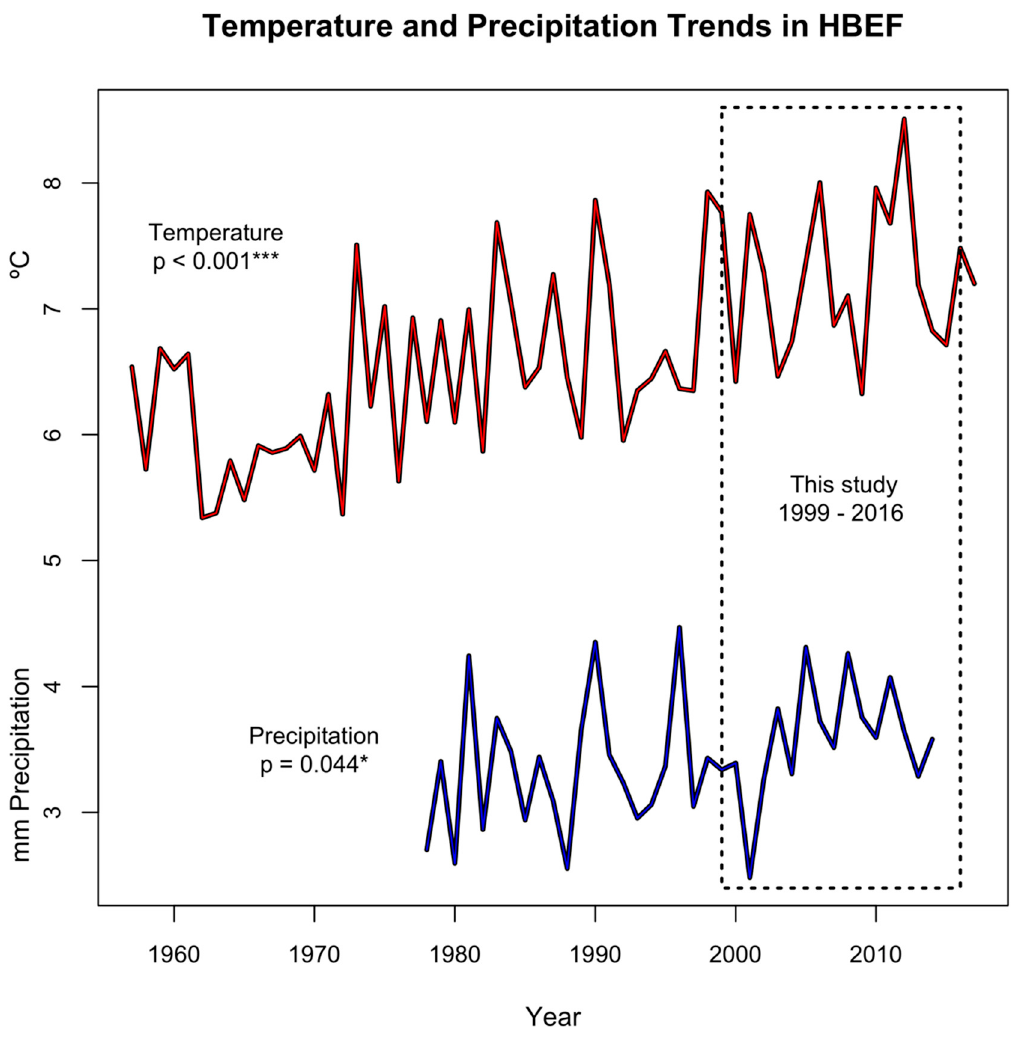
Figure 3. The mean annual temperature (1957 – 2017) and precipitation (1978 – 2014) trends in HBEF, New Hampshire. All data were collected from the USDA Forest Service Headquarters building at HBEF at 252 m above sea